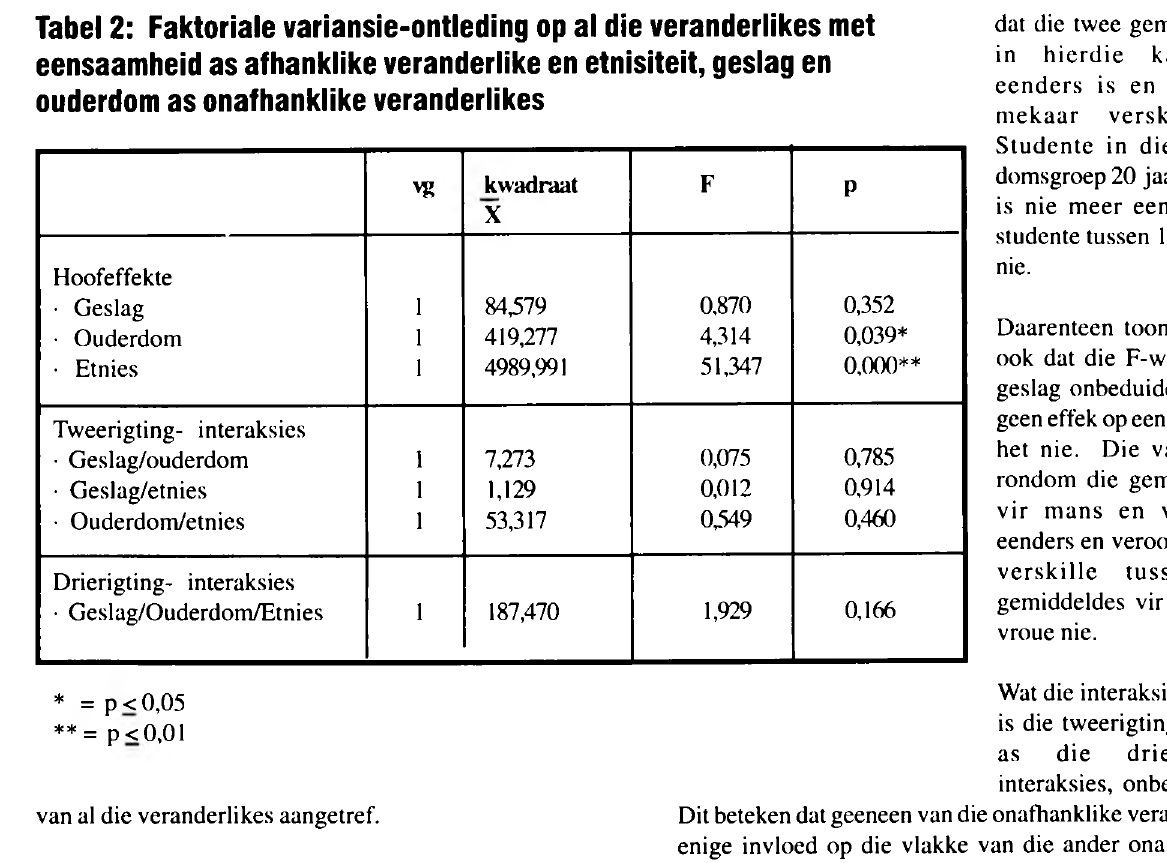
Tabel 2: Faktoriale variansie-ontleding op al die veranderlikes met eensaamheid as afhanklike veranderlike en etnisiteit, geslag en ouderdom as onafhanklike